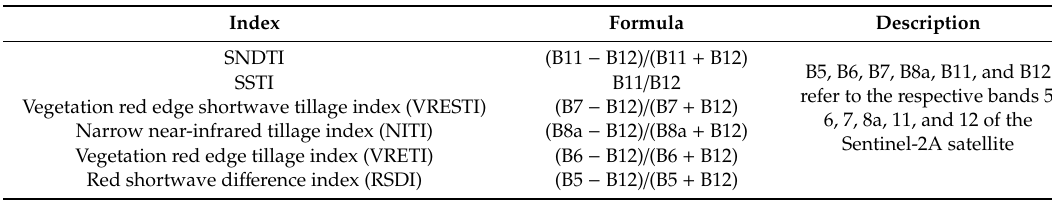
Table 3. Sentinel-2A-based tillage indices.